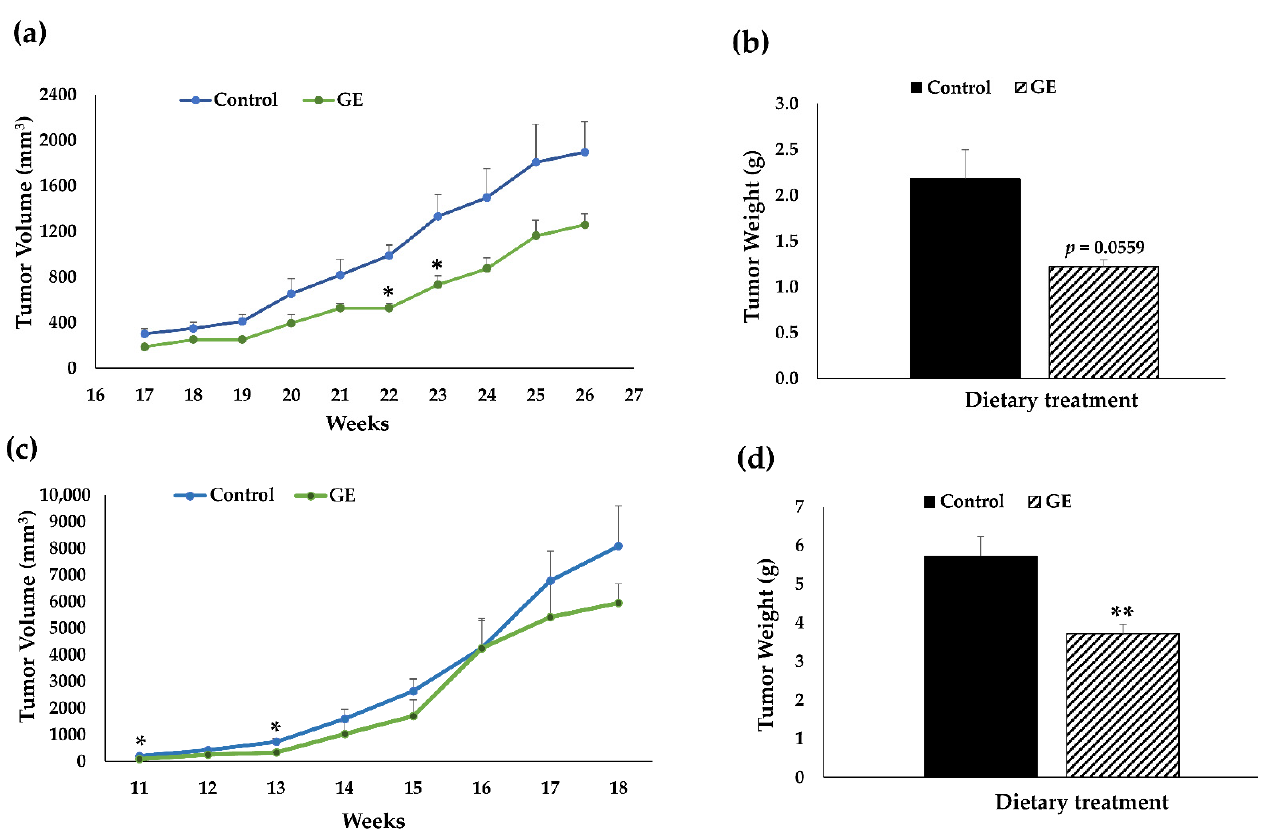
Figure 2. Tumor inhibitory effects of dietary GE on tumor growth in TNBC BCM − 3204 PDX mouse model and TM00091 PDX model. Female NSG mice (5 per group) were implanted PDX tumors at 8 weeks of age and administrated either control or GE diet when primary tumor outgrowth reached 2 mm in diameter. The relevant treatments continued until termination of the experiment. Tumor volumes and weights were observed weekly in BCM − 3204 PDXs ( a , b ) or TM00091 PDXs ( c , d ). ( a , c ) depict tumor volume and ( b , d ) depict tumor weight at termination. (* p < 0.05, ** p < 0.01). Data are presented as mean ± standard error (SE). GE, genistein.